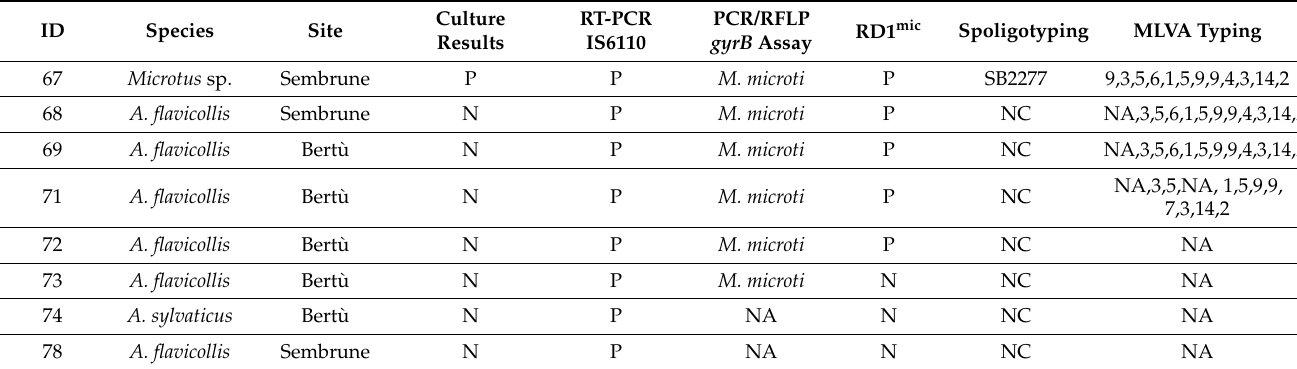
Table 1. Molecular typing results of MTBC-positive rodent tissue samples (P = positive; N = negative, NC = not conclusive, NA = not